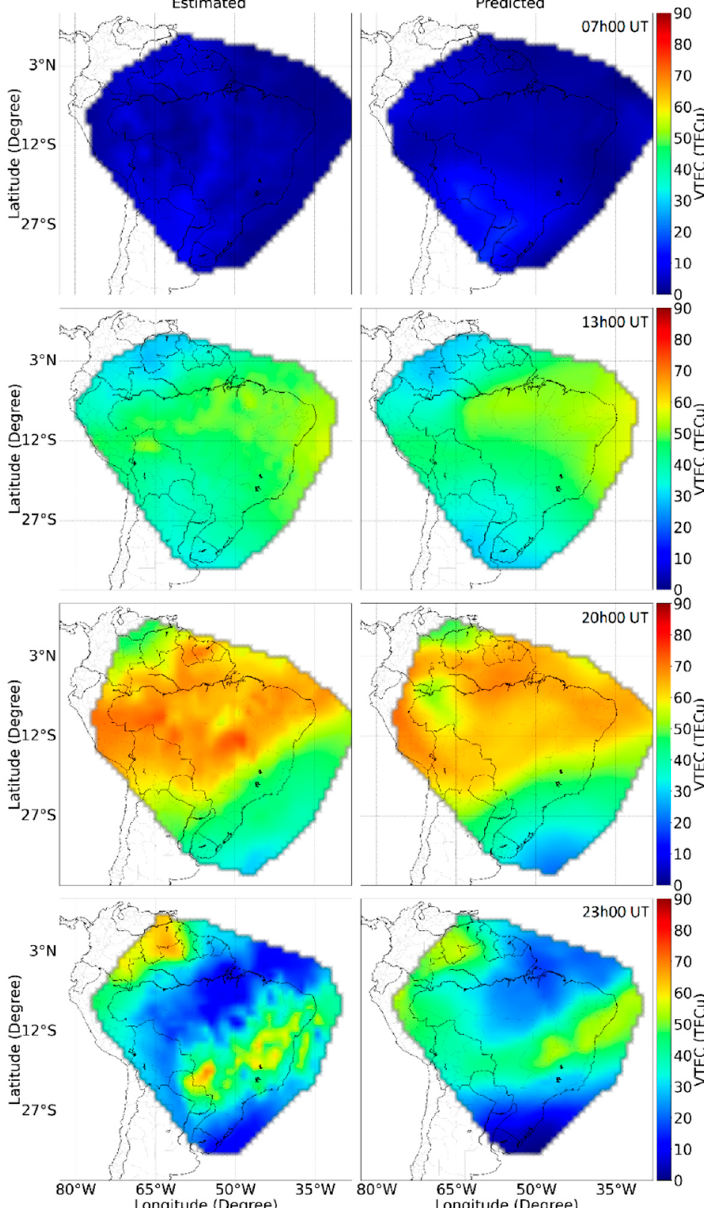
Figure 8. Comparison between the real VTEC maps ( left ) and the VTEC maps predicted with the MLP-NN ( right ) during a summer solstice arbitrary day (30 November 2014). From upper to lower panels, frames corresponding to the post-midnight, morning, afternoon, and early nighttime are presented.